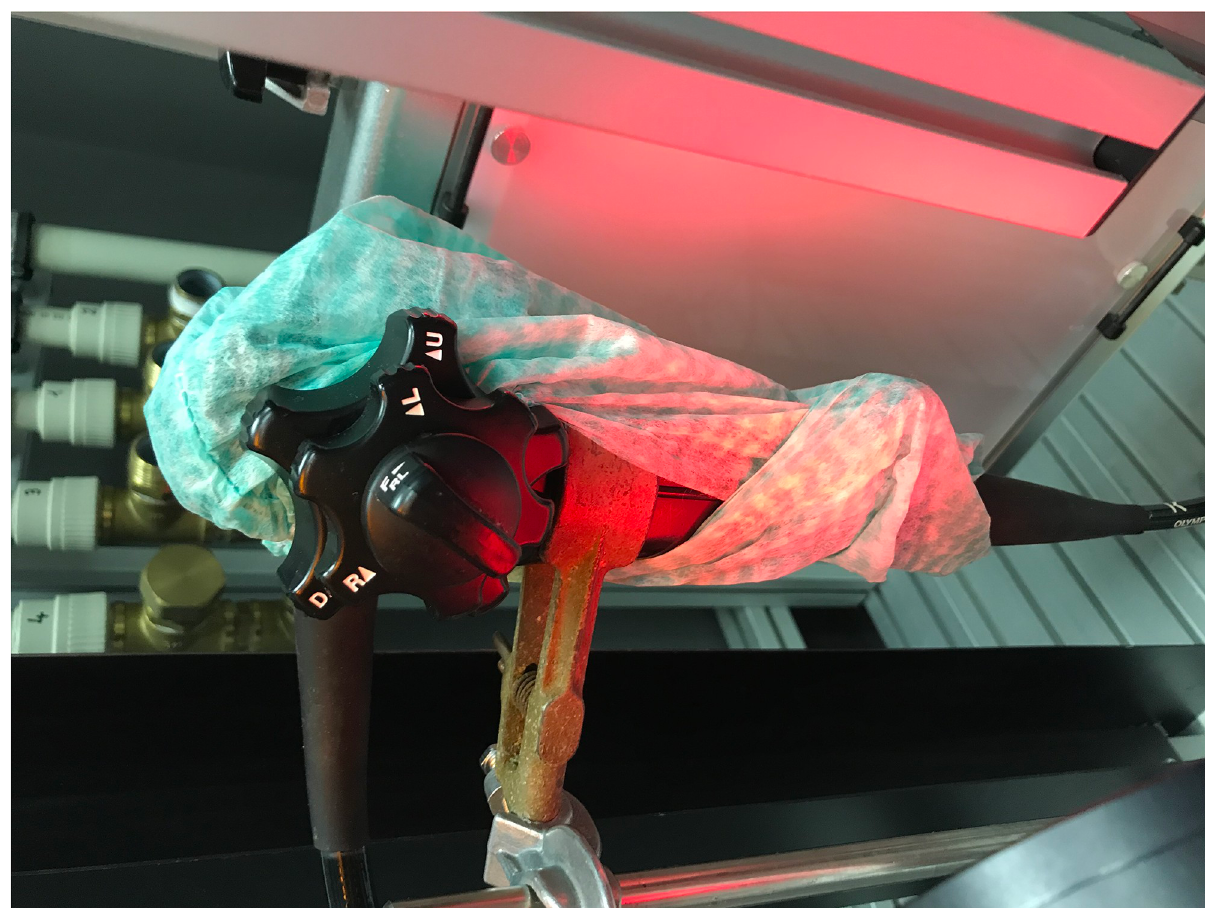
Fig 2. Protective cover. The picture shows a protective cover on an endoscope control body, which was made by wrapping the control body of the endoscope with a surgical